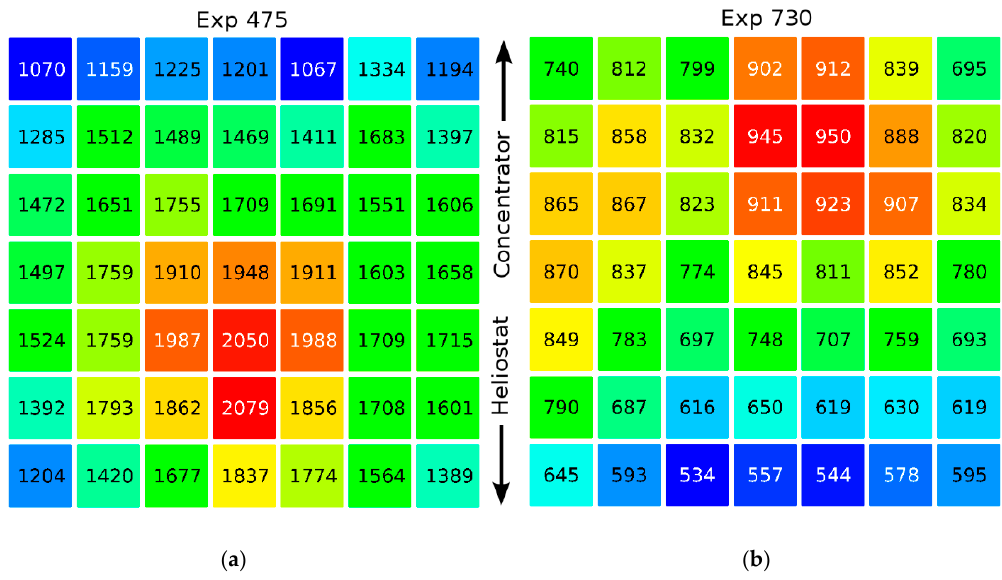
Figure 4. Geometry of the experimental ( a ) and modelling ( b , c ) measurements obtained for planes 475 and 730. The colour profiles shown for the two detectors emulate the values obtained for experimental (Figure 5) and modelling data (shown later in Figures 7 and 9).